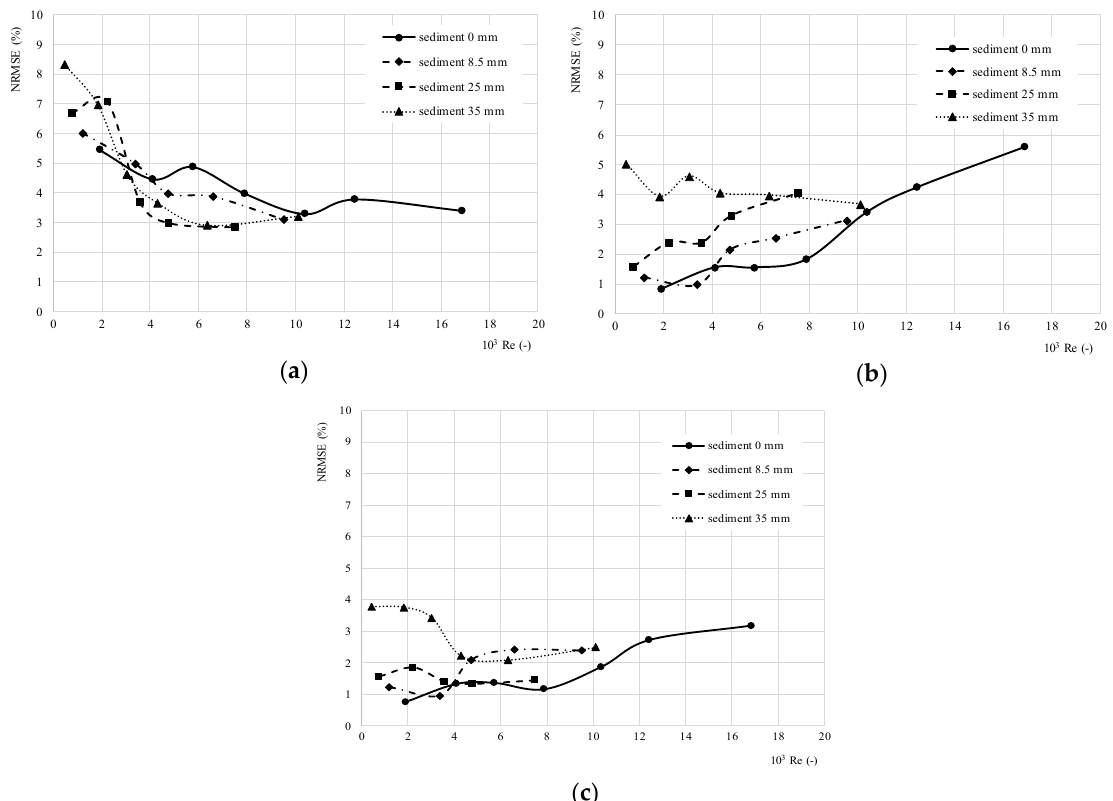
Figure 4. Normalised root mean square error (NRMSE) for ( a ) the Gaussian approximation function according to Equation (3), ( b ) the Gumbel approximation function according to Equation (4) and ( c ) the GEV approximation according to Equation (5). Graphical presentation and evaluation of relations between dispersion coefficient and Table 1. Summary of the tracer experiments results. basic hydraulic parameters (flow velocity and Reynolds number) on the basis of results of the experiments are shown in Figures